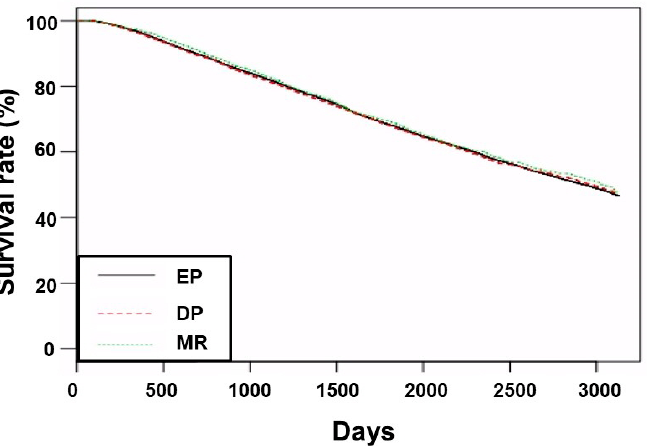
Figure 1. Kaplan–Meier curves of patient survival according to group. Abbreviations: EP, group treated with short-acting erythropoiesis-stimulating agents; DP, group treated with intermediate- acting erythropoiesis-stimulating agents; MR, group treated with long-acting erythropoiesis-stimu- lating agents.